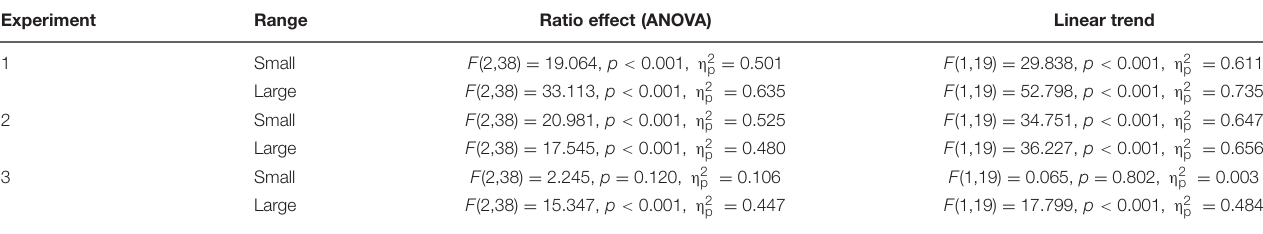
TABLE 1 | Results of the three experiments in the absence of arrays composed by a single dot [only 0.50 (2 vs. 4) / 0.67 and 0.75 numerical ratios].